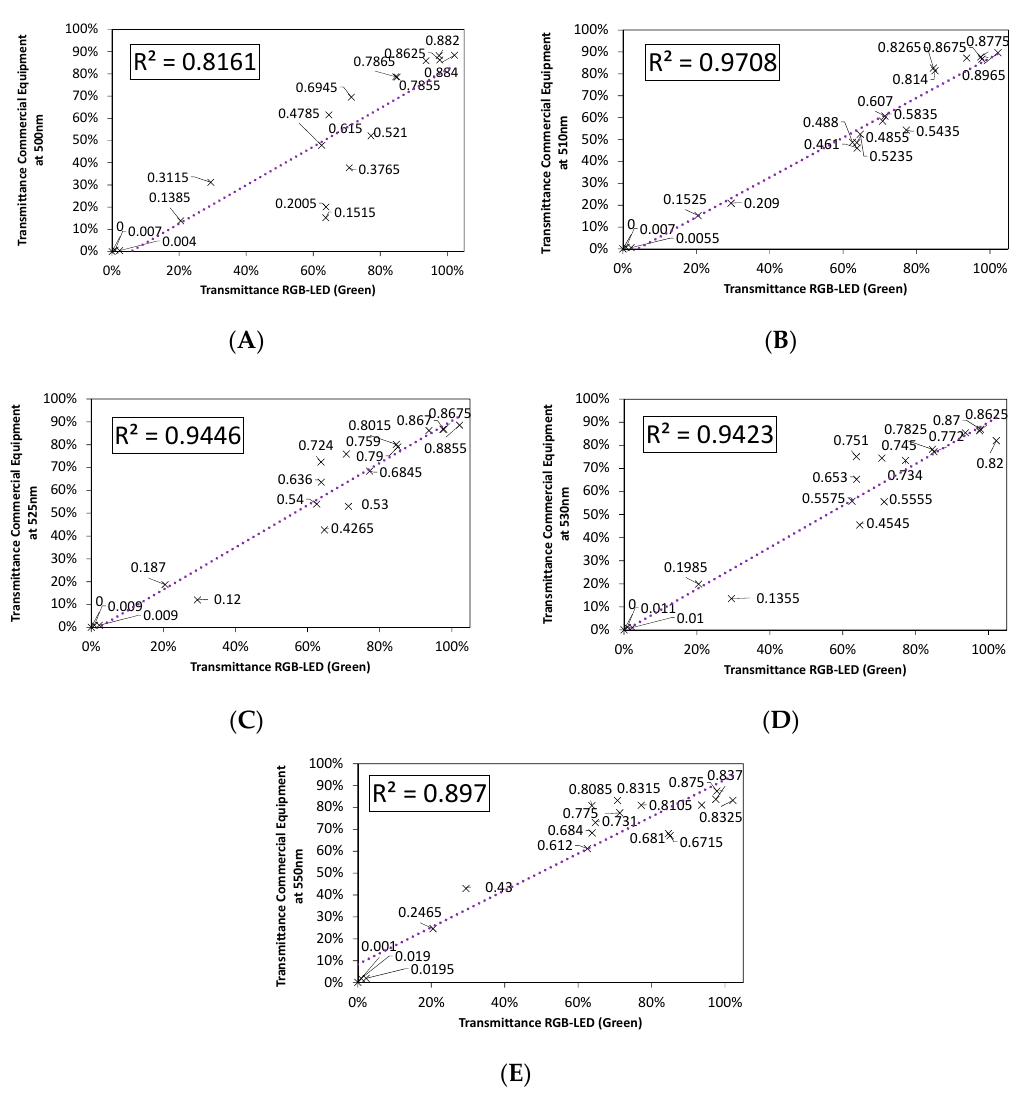
Figure 9. Comparison of the fit for the emission spectrum of the green LED to: ( A ) 500 nm, ( B ) 510, ( C ) 525 nm- λ Peak, ( D ) 530 nm, and ( E ) 550 nm.